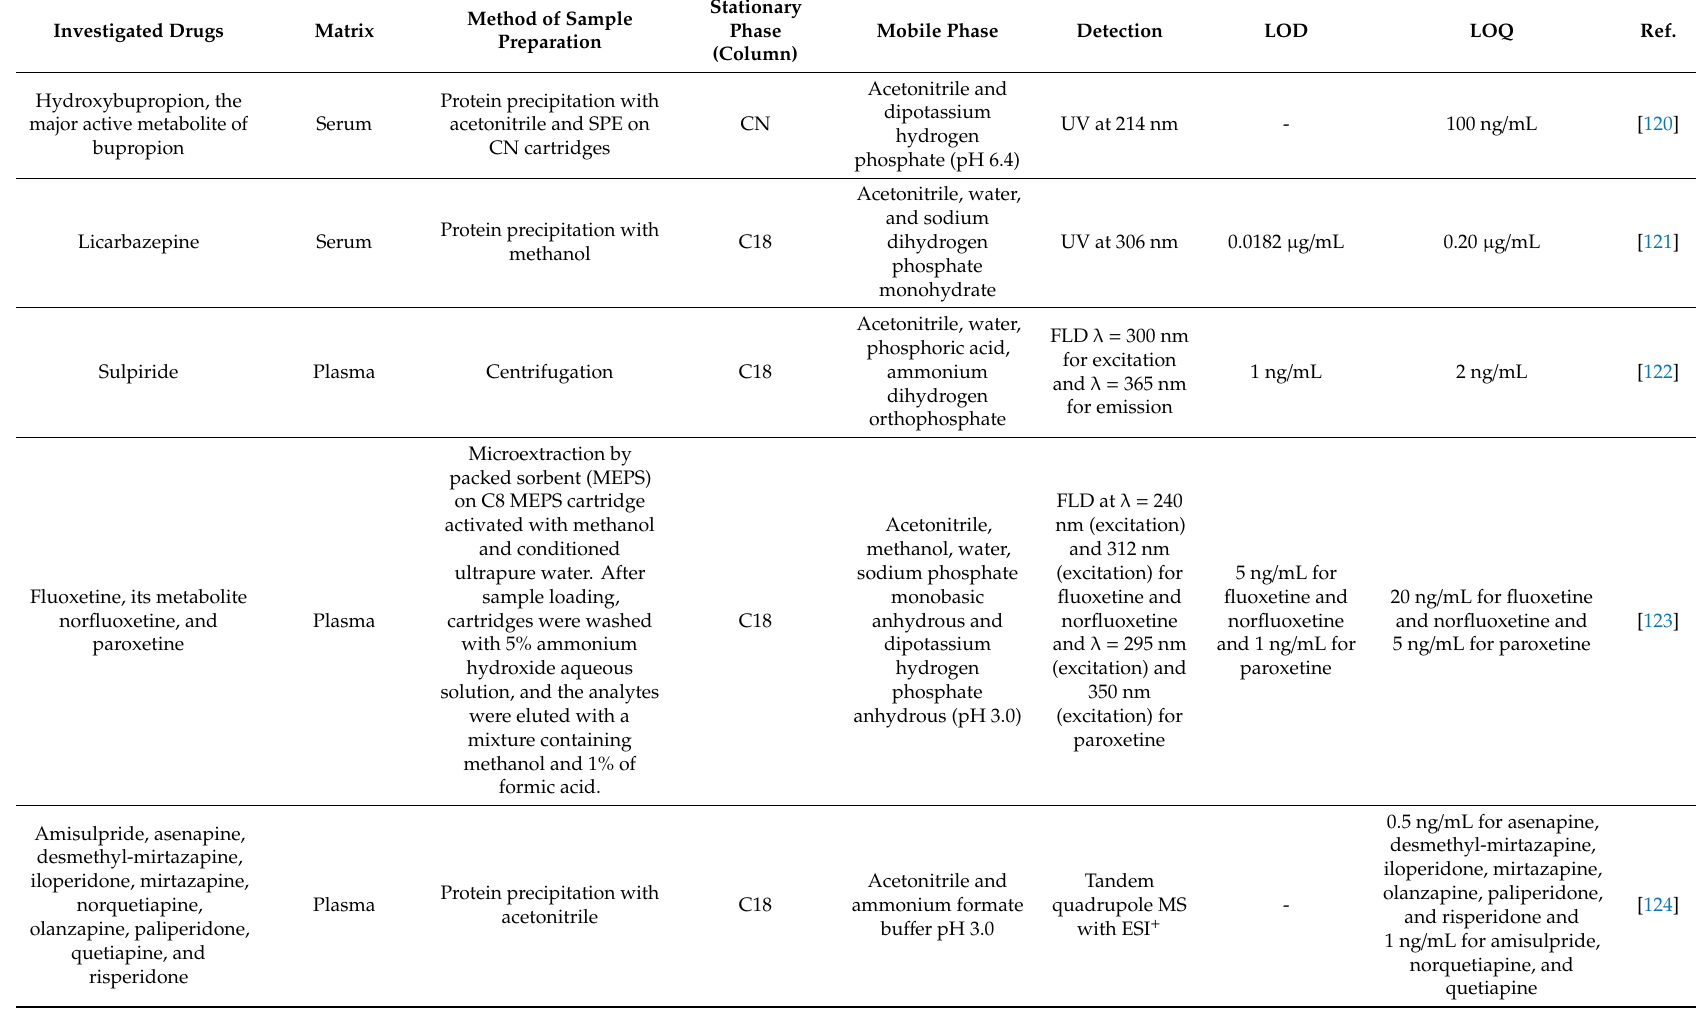
Table 7. Psychotropic drugs. FLD: fluorescence